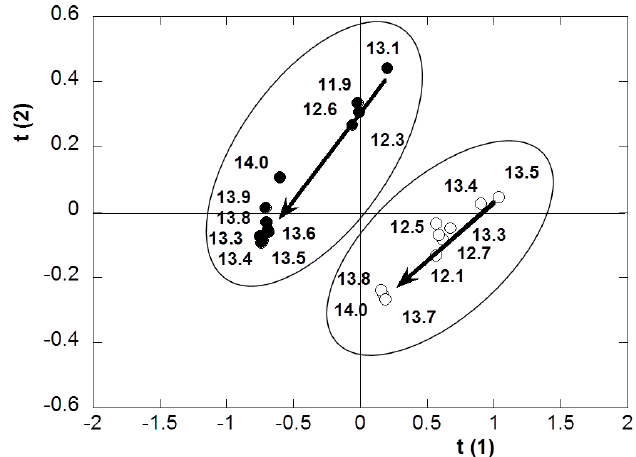
Figure 5. Projection of the Sclg (filled circles) and Sclg/borax (empty circles) absorption spectra onto the space spanned by the first two principal components (PCs). The arrows indicate the transition observed in the spectra at pH = 13.1 (Sclg) and pH = 13.5 (Sclg/borax). The CD spectra (Figure 6), corresponding to the absorption band of CR, were acquired at pH 9 and 14. At pH 9, a well-defined band is present in both the Sclg and Sclg/borax samples. For the Sclg/borax sample a higher induced CD signal is registered, due the presence of borax, which affects the mobility of the lateral domains of Sclg chains [8].